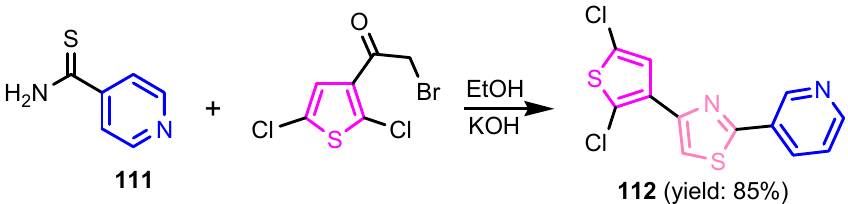
Scheme 23. Synthesis of 4-(2,5-dichlorothiophen-3-yl)-2-(pyridin-3-yl)thiazole 112 [51].